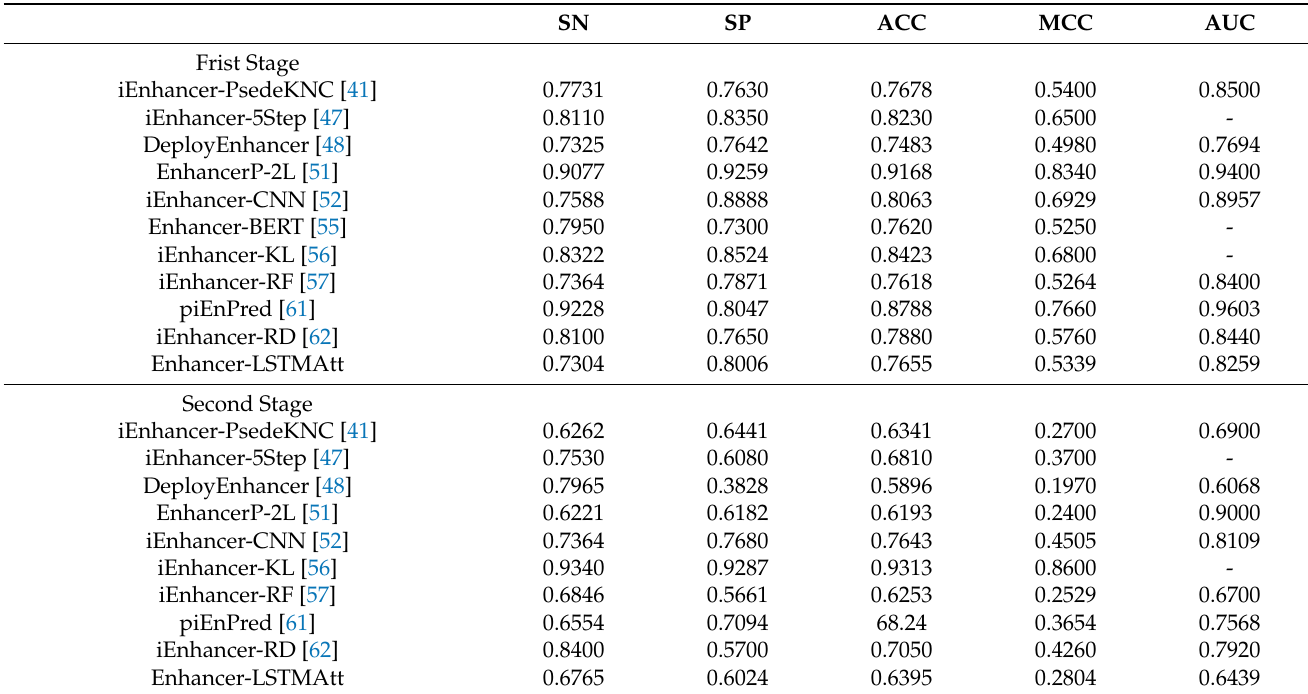
Table 4. Comparison with state-of-the-art methods by 5-fold cross